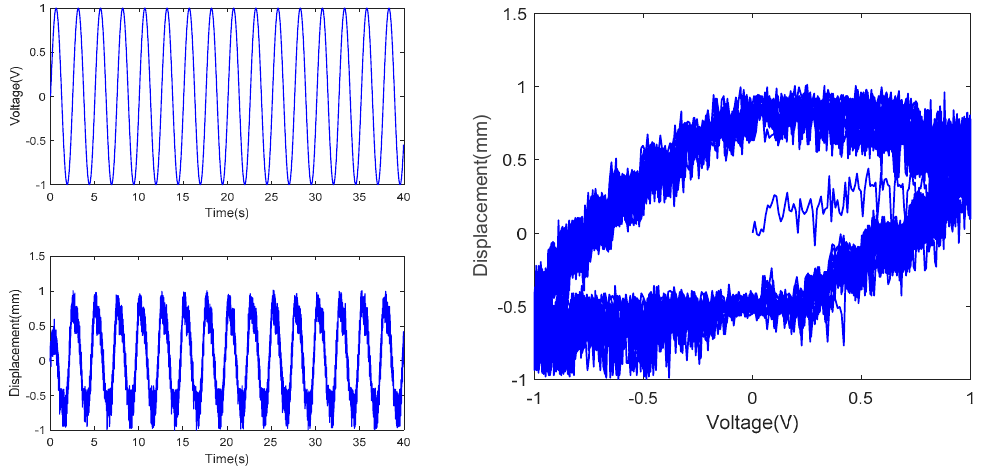
Figure 5. Tip displacement at actuating voltage with amplitude of 1V and frequency of 1/2 π Hz. Figure 6. Tip displacement at actuating voltage with amplitude of 1V and frequency of 1 / 2 π Figure 29. Error of the LSSVM-NARX model at random sinusoidal actuating voltage II (RMSE = 0.9606).